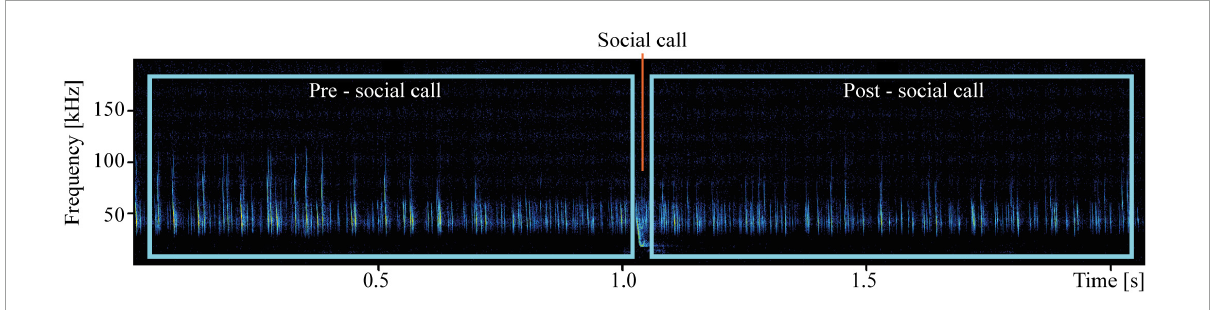
FIGURE1 One second of overlapping echolocation calls from multiple swarming bats (“swarming soundscape”) before and after a social call was produced. The swarming soundscape was analyzed to extract acoustic parameters and assign the social call to a predominantly calling species based on a set of identified reference